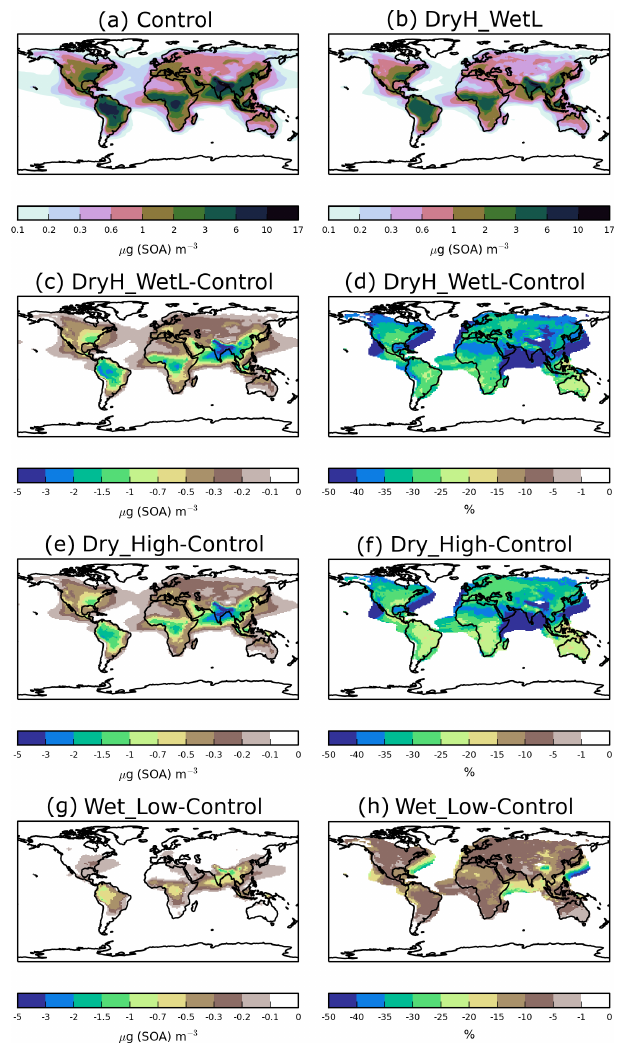
Figure 3. Annual-average surface SOA concentrations for (a) Con- trol and (b) DryH_WetL simulations, and absolute and percent- age differences in annual-average surface SOA concentrations for (c, d) DryH_WetL, (e, f) Wet_Low, and (g, h) Dry_High simula- tions relative to